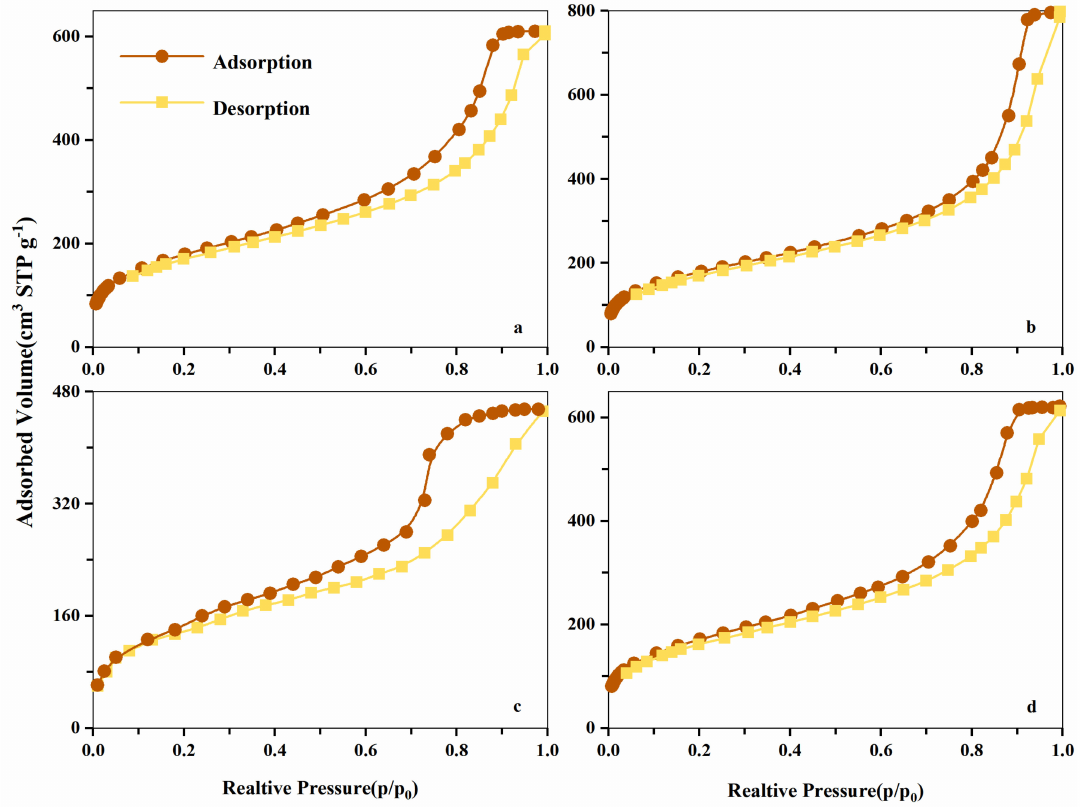
Figure 3. N 2 adsorption isotherms of NDA-1 ( a ), NDA-2 ( b ), NDA-3 ( c ) and NDA-4 ( d ) resins at 77